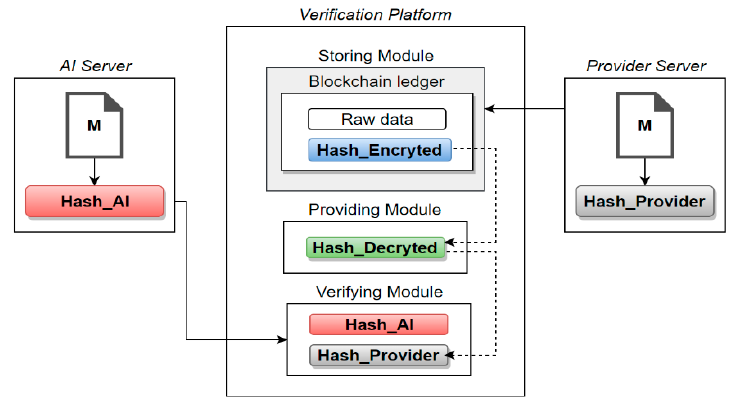
Figure 5. Process of verification for AI data.